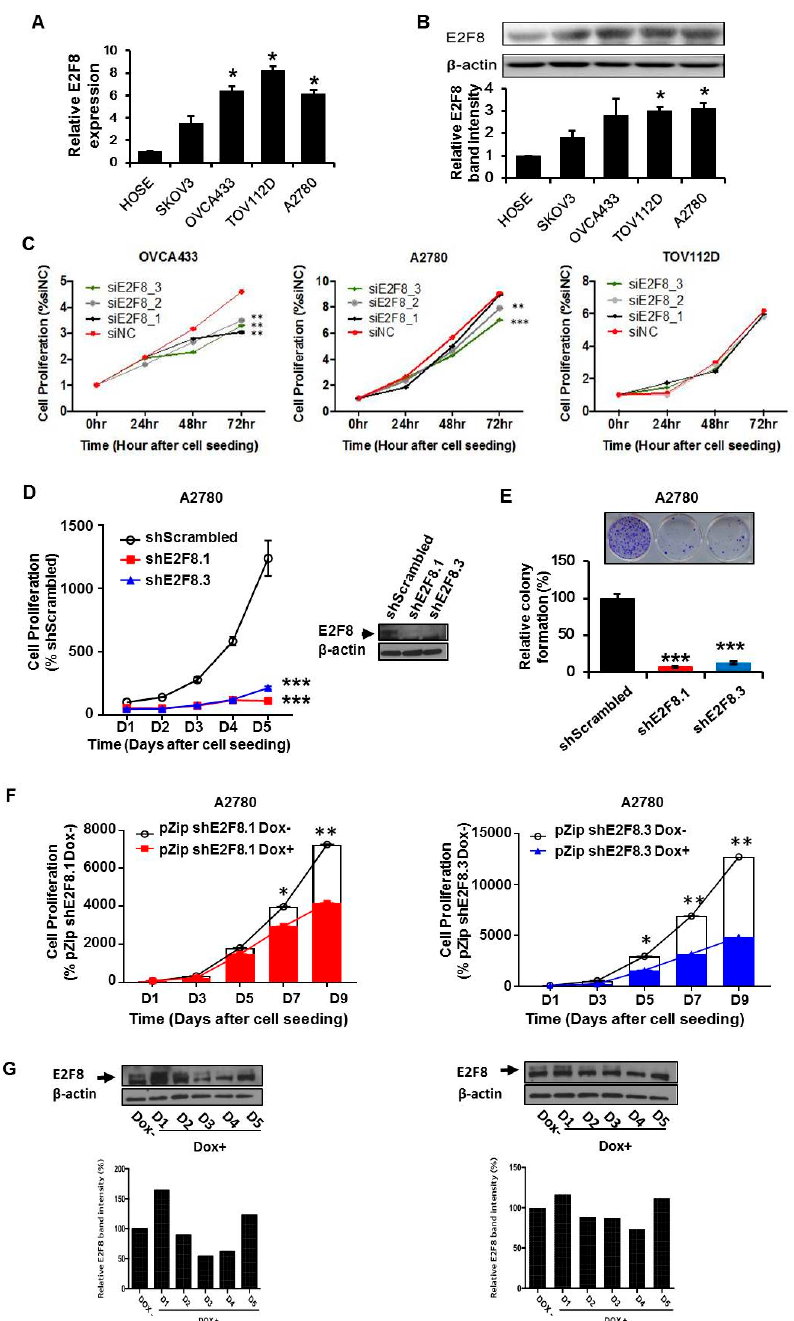
Figure 2. E2F8 expression in ovarian cancer cell lines and correlation with suppressed cell proliferation. ( A , B ) The knockdown validation data are shown in Supplement Figure 1. Expression levels of E2F8 mRNA and protein in some ovarian cancer cell lines (OVCA433, TOV112D, and A2780) and normal control cells. (C ) The e ff ect of E2F8-targeting siRNA (siE2F8)-transfection on cell proliferation in multiple cell lines. (D ) Proliferation of shRNAs targeting E2F8 (shE2F8)-transfected A2780 cell line. ( E ) Colony formation in E2F8-knockdown A2780 cells. ( F ) Proliferation of doxycycline-inducible shE2F8.1- or shE2F8.3 -expressing stable A2780 cell lines in the presence or absence of doxycycline. ( G ) Doxycycline-inducible shE2F8.1- and shE2F8.3-transfected stable A2780 cell line was established. After treatment with doxycycline, protein lysates were obtained daily from day 1 to 5, and E2F8 protein expression was assessed * p < 0.05, ** p < 0.01, *** p <